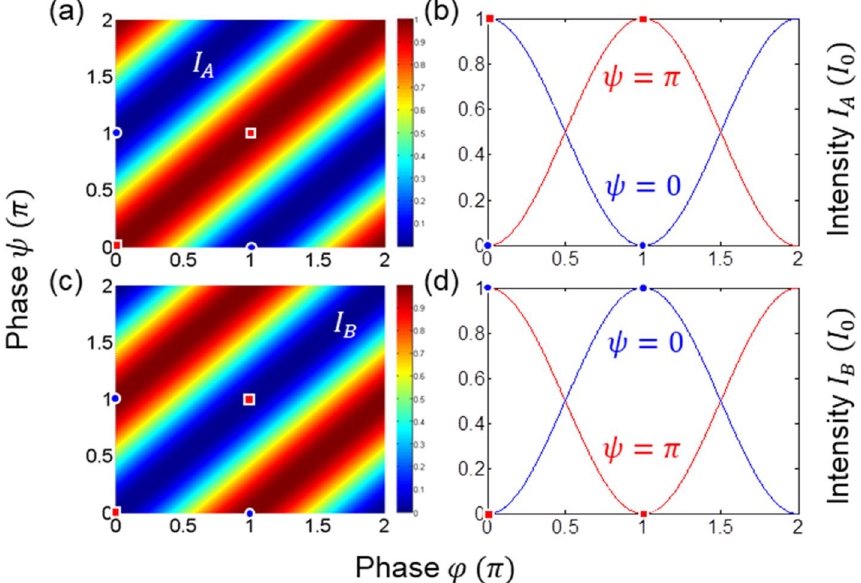
ϕ 12 ; ψ ψ 12 . ( a )–( d ) Red square (blue dot) indicates identity = =